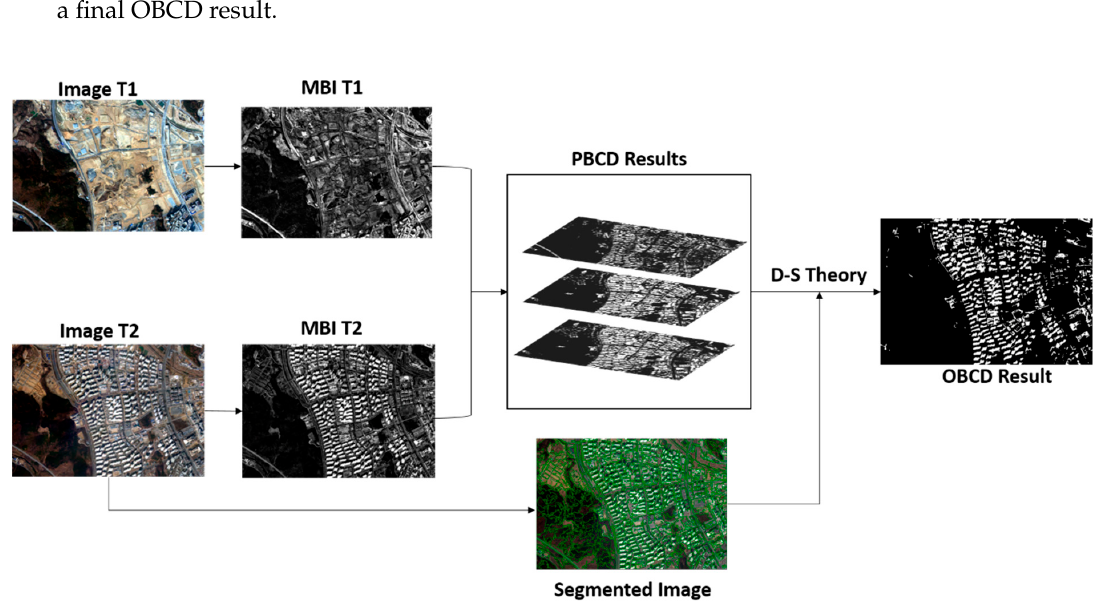
Figure 1. Flowchart of the proposed method.